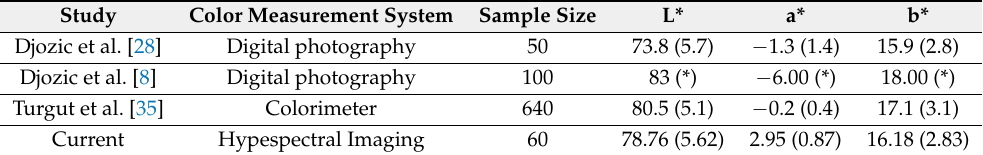
Table 2. Overview of means and standard deviations of Upper Central Incisors CIE-L*a*b* values obtained with different color measuring systems used for tooth color determinations in Dentistry.